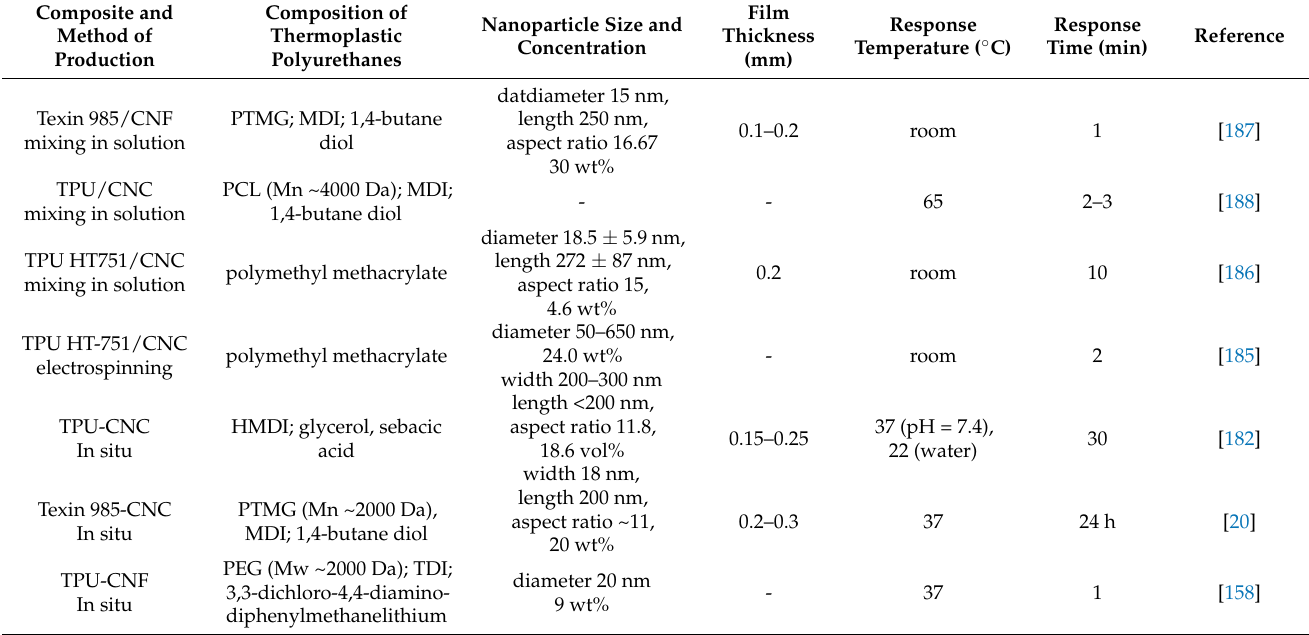
Table 2. Comparison of shape recovery rates in water for TPU composites with SME contain- ing